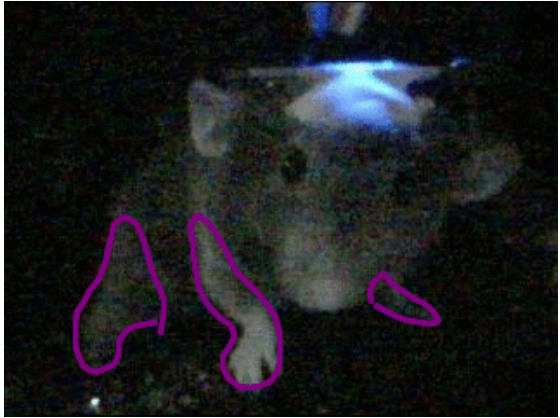
Figure 1. Frontal view of a mouse with its moving limbs marked.